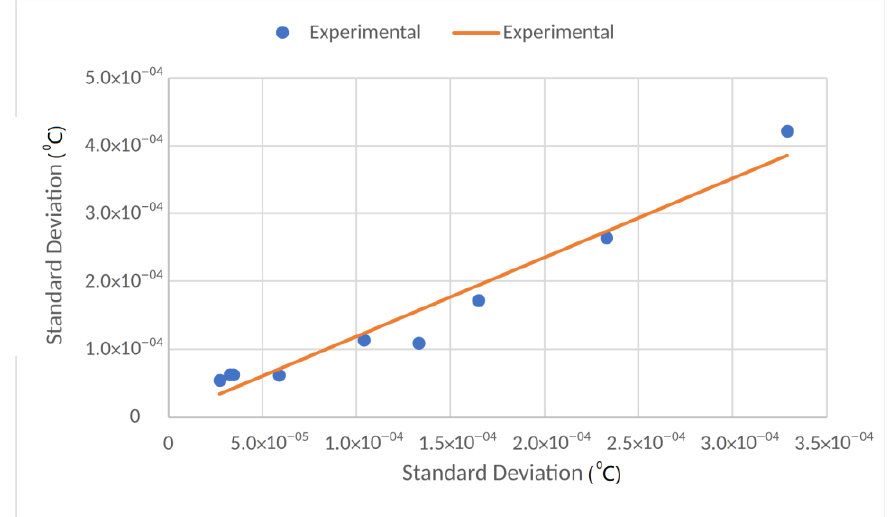
Figure 14. Correlation between experimental and estimated standard deviations.